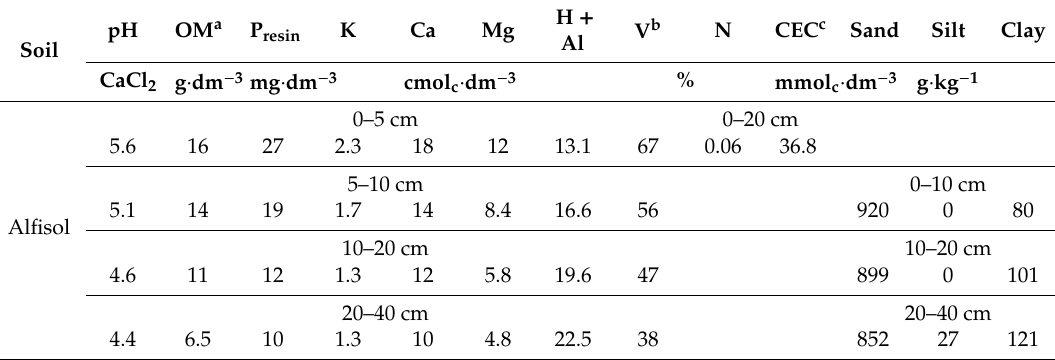
(Supplementary Appendices Table S1) per plot of di ff erent ecological groups; planting density was 2500 individuals per